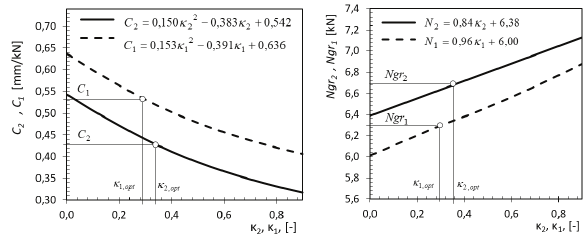
Figure 5: Relationship obtained during the M-K approximation for pile 1.